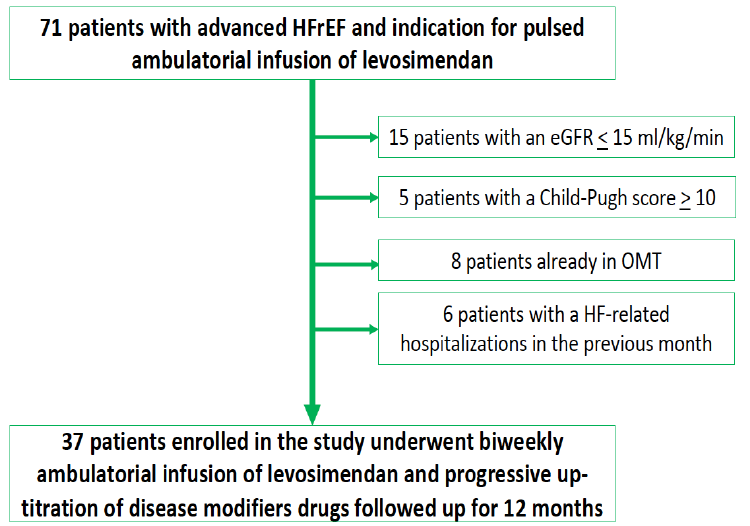
Figure 1. Study protocol. eGFR: estimated glomerular filtration rate. OMT: optimal medical therapy. HF: Heart failure. HFrEF: heart failure with reduced ejection fraction.